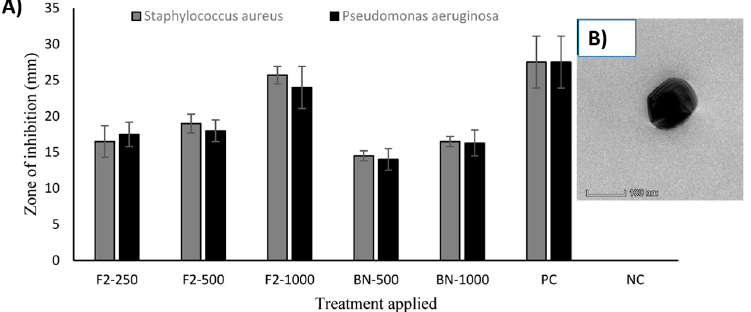
Figure 2. Antimicrobial activity of chitosan-curcumin nanoparticles against Staphylococcus aureus and Pseudomonas aeruginosa ( A ). The optimized formulation showed well-defined morphology ( B ). The figures were taken and combined from the literature